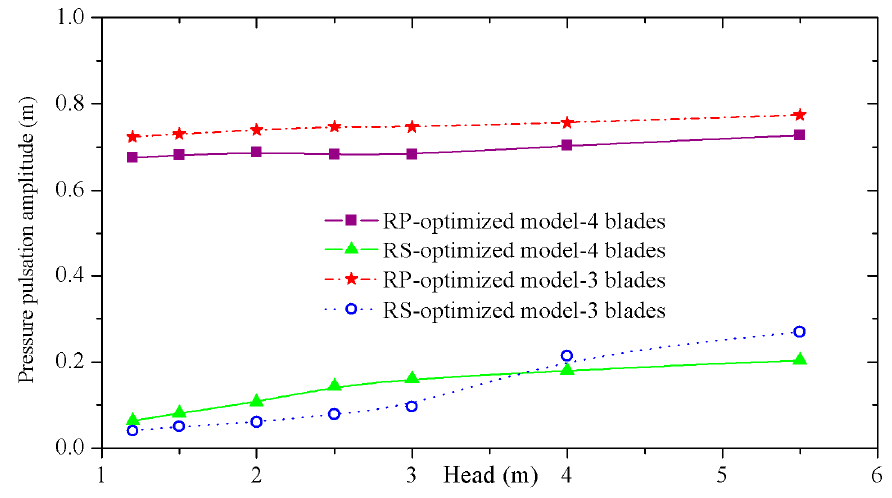
Figure 14. Pressure pulsation amplitudes with dominant frequency of 1 f n on blade points RP and RS for the ebb turbine mode.